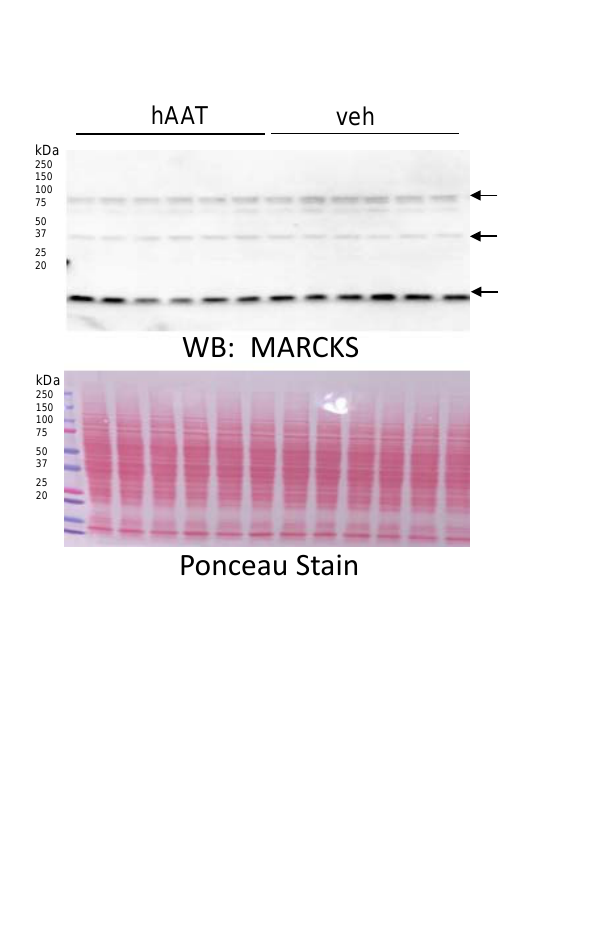
fraction of kidney cortex lysates from diabetic db/db mice treated with hAAT compared to vehicle (Figure 5).